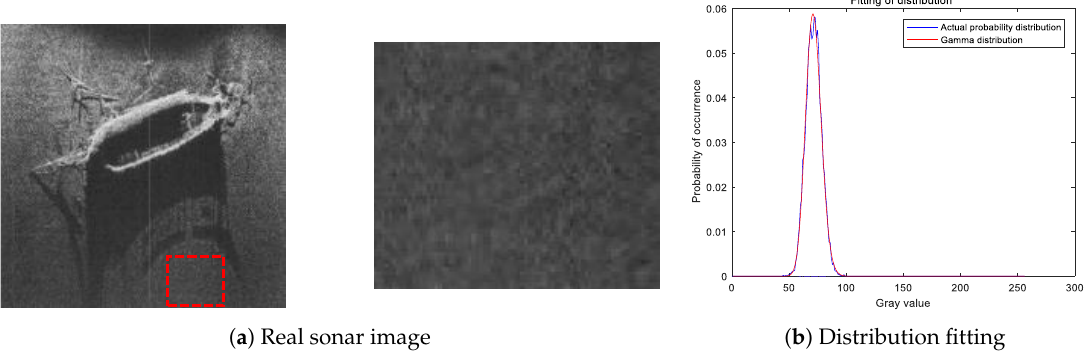
Figure 2. Statistical distribution and fitting for the real sonar image background.